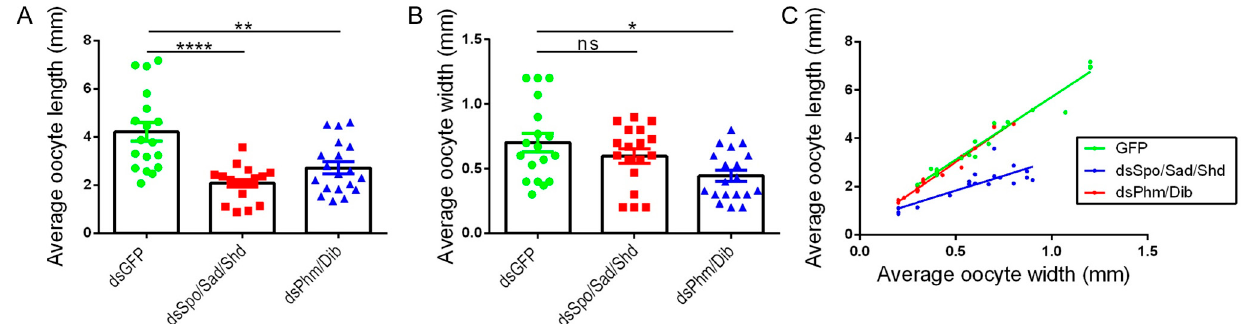
Figure 4. Oocyte development in adult females that were injected with a combination of dsSpo , dsSad and dsShd or with a combination of dsPhm and dsDib . ( A , B ) The average length ( A ) or the average width ( B ) of five basal oocytes per female locust twelve days after the final molt and per condition are represented as mean ± S.E.M.; each dot represents one data point ( n = 15). Significant differences are indicated by (an) asterisk(s) (**** p < 0.0001; ** p < 0.01, * p < 0.05 and ns = ‘not significant’; Kruskal–Wallis test with Dunn’s Multiple Comparisons Test). ( C ) The data represent the average length (Y-axis) and width (X-axis) of five basal oocytes collected from dsSpo / Sad / Shd -, dsPhm / Dib -, or dsGFP -treated females twelve days after the final molt (coloured dots), as well as the linear regression (coloured lines) ( n = 15 per condition). The Pearson‘s correlation coefficients for the dsSpo / Sad / Shd , dsPhm / Dib and dsGFP knockdown conditions are 0.8276, 0.9824 and 0.9778, respectively ( p < 0.0001 in all conditions). The linear regression curve of dsSpo / Sad / Shd is significantly different from the control condition ( p < 0.0001; ANCOVA).